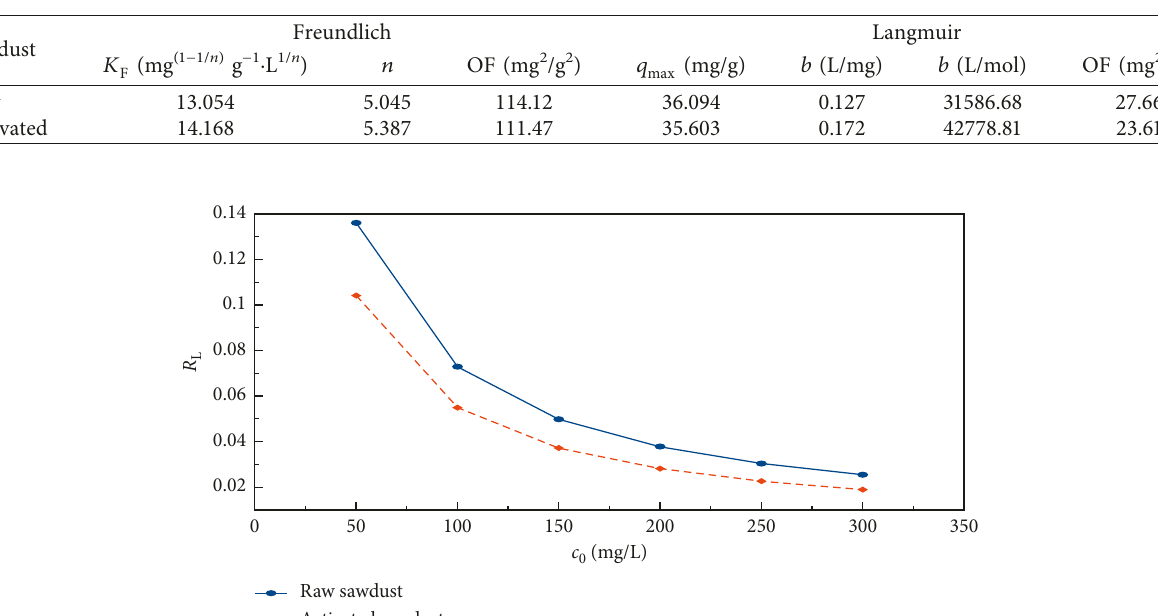
Table 3: Comparison of the optimized Freundlich and Langmuir isotherms parameters for the adsorption of chrysoidine on raw and activated sawdust.